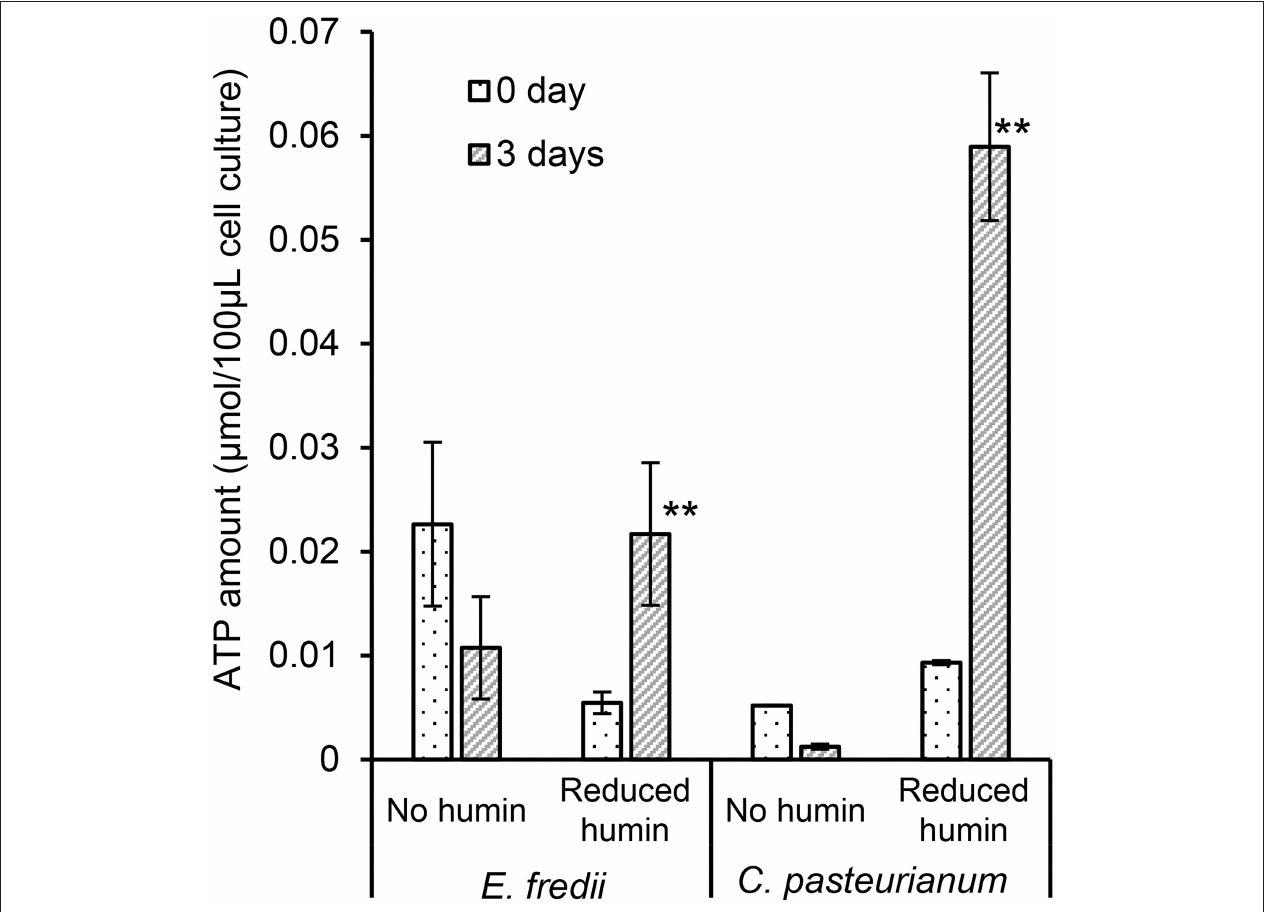
FIGURE 5 | Effect of the reduced humin on the changes in ATP amount of washed and starved E. fredii and C. pasteurianum under the conditions with no humin and reduced humin during 3 days of incubation. Ensifer fredii was incubated under molybdenum conditions, and C. pasteurianum under vanadium conditions, respectively. No organic carbon source was added to the culture medium. Abiotic controls did not show any increase in ATP amount regardless of the presence of reduced humin (data not shown). Error bars represent the standard deviation of triplicate measurements. The symbols “*” and “**” indicate significant differences at p < 0.05, and p < 0.01,